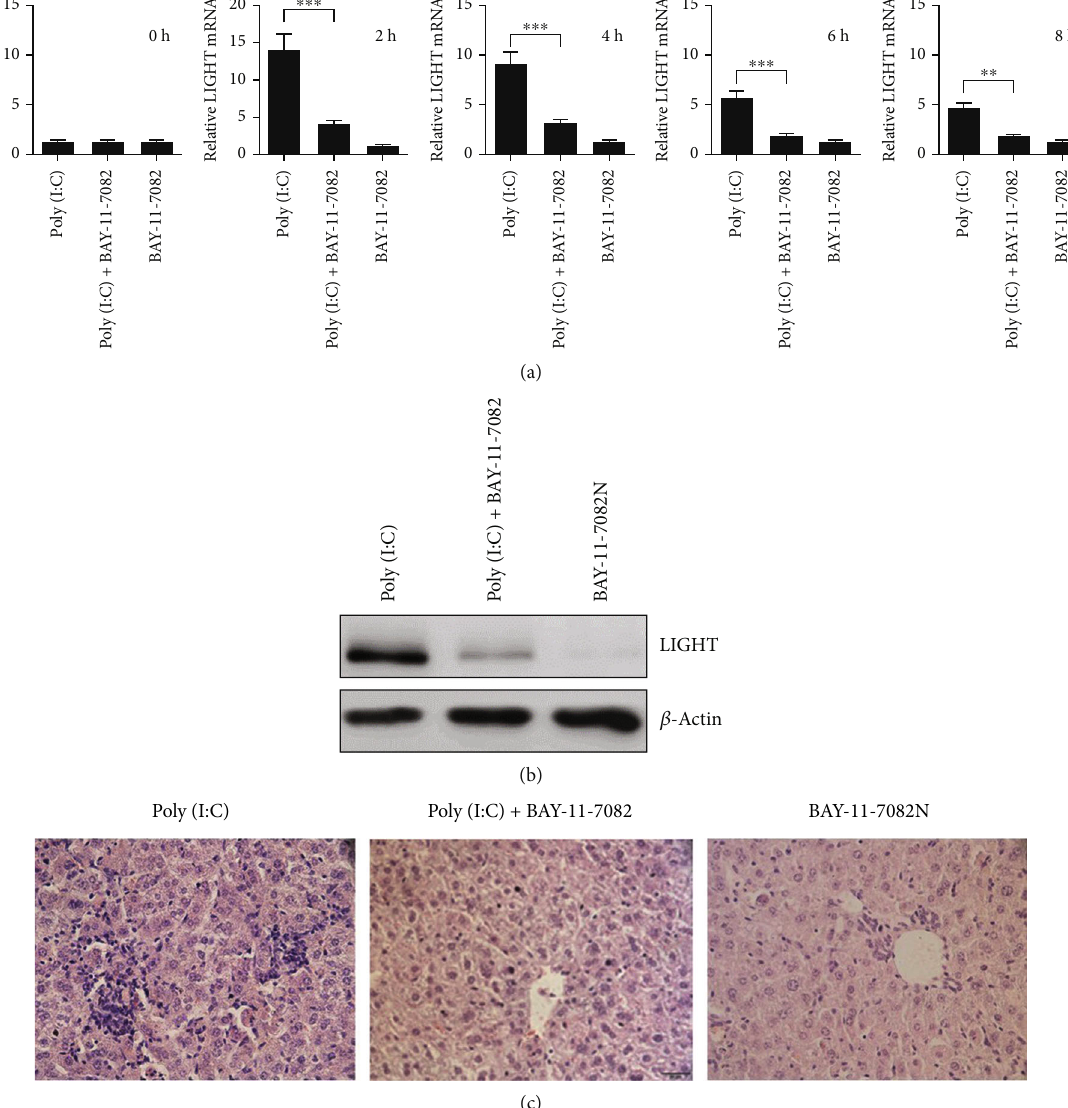
Figure 4: TLR3-induced LIGHT expression through activation of NF- κ B. (a) BALB/c mice were injected with poly(I:C) (1.5 μ g/mouse) and D- GalN(10mg/mouse). Mice were pretreated with NF- κ B inhibitor (BAY-11-7082) one hour before poly(I:C) injection. The mice were sacri fi ced and total RNA was extracted from the livers. Expression of LIGHT mRNA was measured by real-time PCR at the indicated time points, and data are shown as mean + SEM ; ∗∗ p < 0 : 01 , ∗∗∗ p < 0 : 001 . (b) Expression LIGHT protein was analyzed by western blot at 12h after poly(I:C) injection. (c) Mice were sacri fi ced at 24h, the liver tissues were fi xed and stained with H&E (size bar represents 20 μ